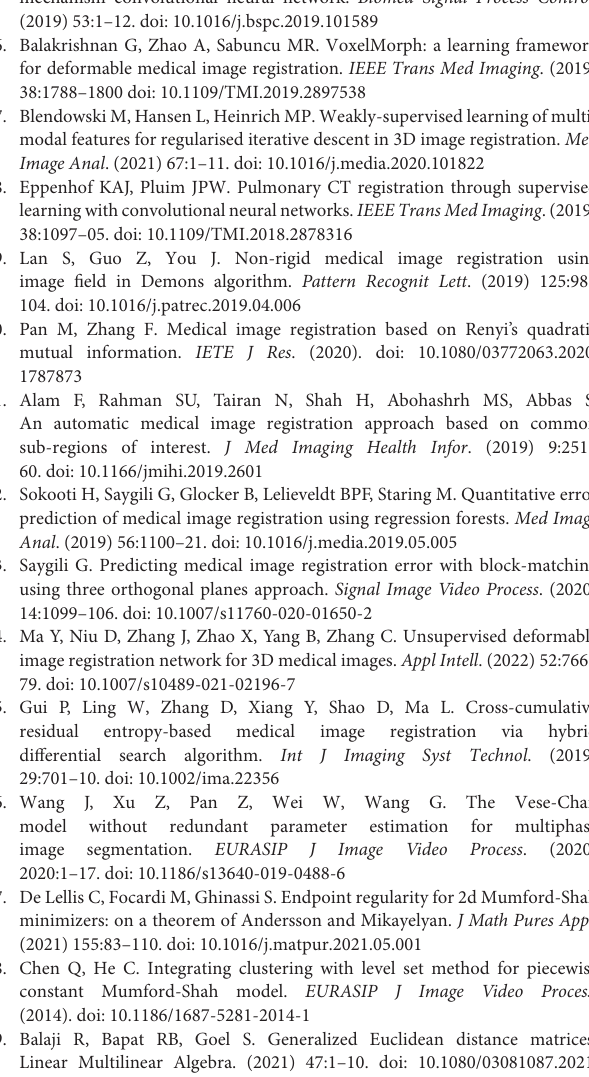
algorithm and Grub cut for MRI images segmentation, Proc Int Conf Intell Syst . (2021) 186:316–22. doi: